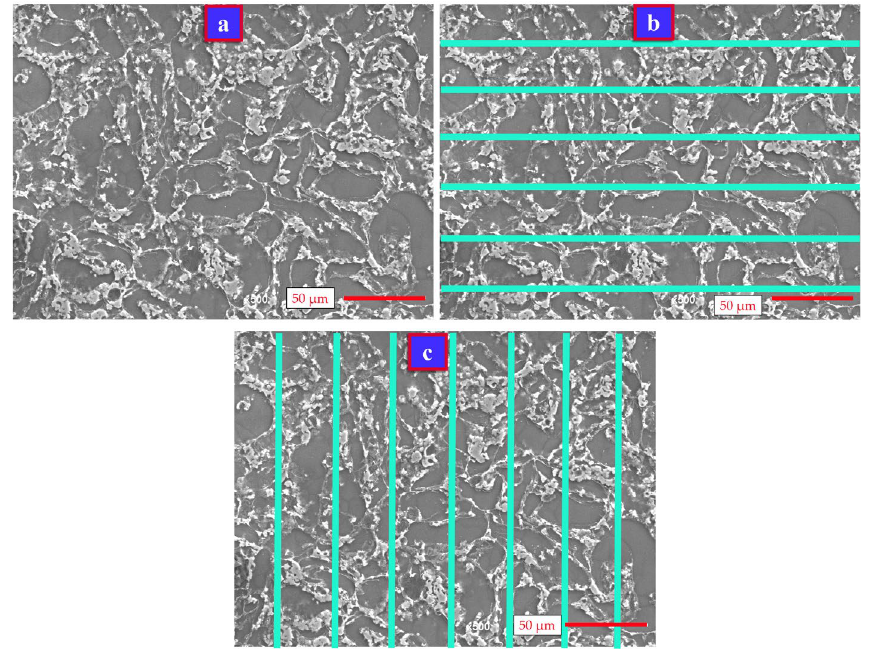
Figure 1. Manual grain counting method: ( a ) original SEM image of sample 1, ( b ) measuring by horizontal, ( c ) measuring by vertical.